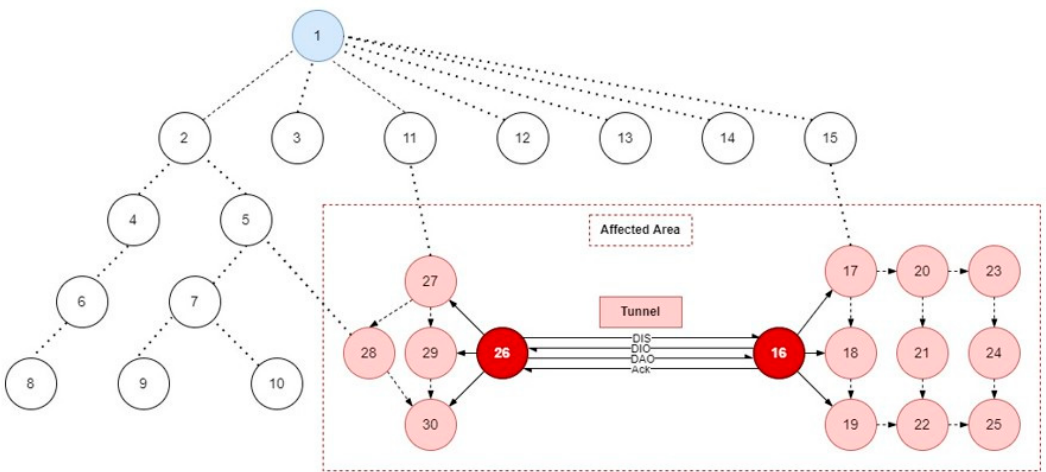
Figure 3. SN-inherited attack simulation in RPL-based IoT network simulated in Cooja.